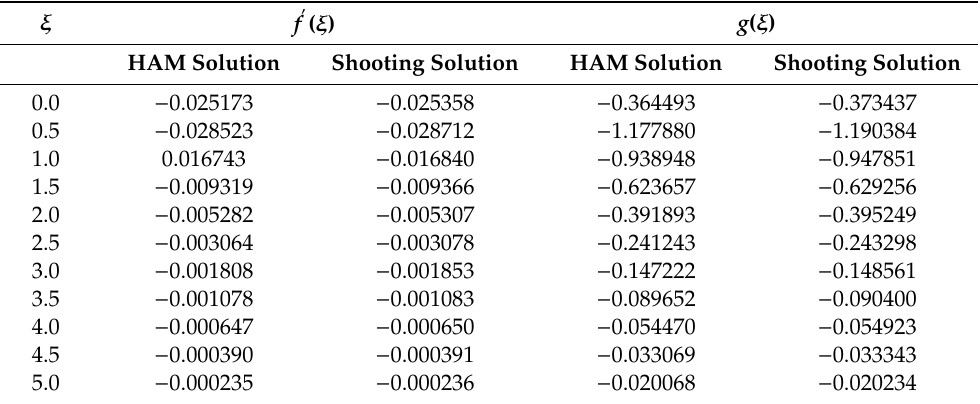
Table 4. Comparison of HAM and Shooting techniques for f (cid:48) ( ξ ) and g ( ξ ) while considering other